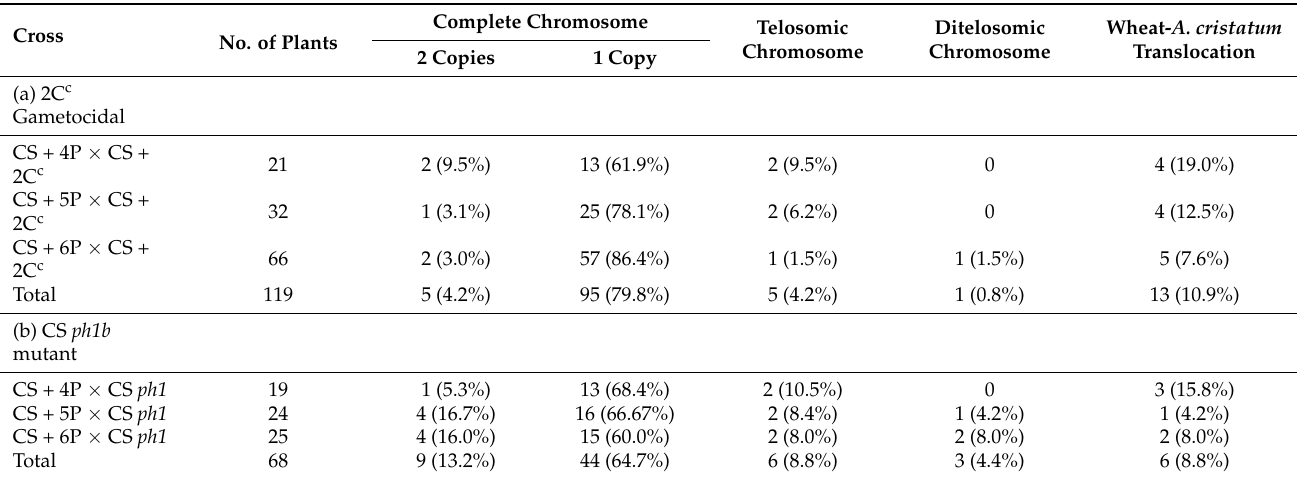
Figure 2. Genotypic assays for the presence of A. cristatum introgressions and Ph1. ( a ) The presence of P genome introgression from A. cristatum (lanes 4, 6, 7, 9 and 12) is marked by the successful amplification of the AcOPx11-817 fragment. ( b ) The absence of Ph1 is marked by the ABC920 SCAR marker (individuals 1-8). M: size marker; CS: Triticum aestivum cv Chinese Spring; P: Agropyron cristatum ; Ph1+ : wild type wheat CS; ph1- : the parental ph1b mutant. Table 2. Transmission of P-genome chromatin and wheat- A. cristatum translocations. (a) F 2 plants from crosses between the disomic addition line for chromosomes 4P, 5P and 6P, respectively, and the CS disomic addition line for gametocidal 2C c chromosome; (b) BC 1 F 2 plants from crosses between the disomic addition line for chromosomes 4P, 5P and 6P, respectively and CS ph1